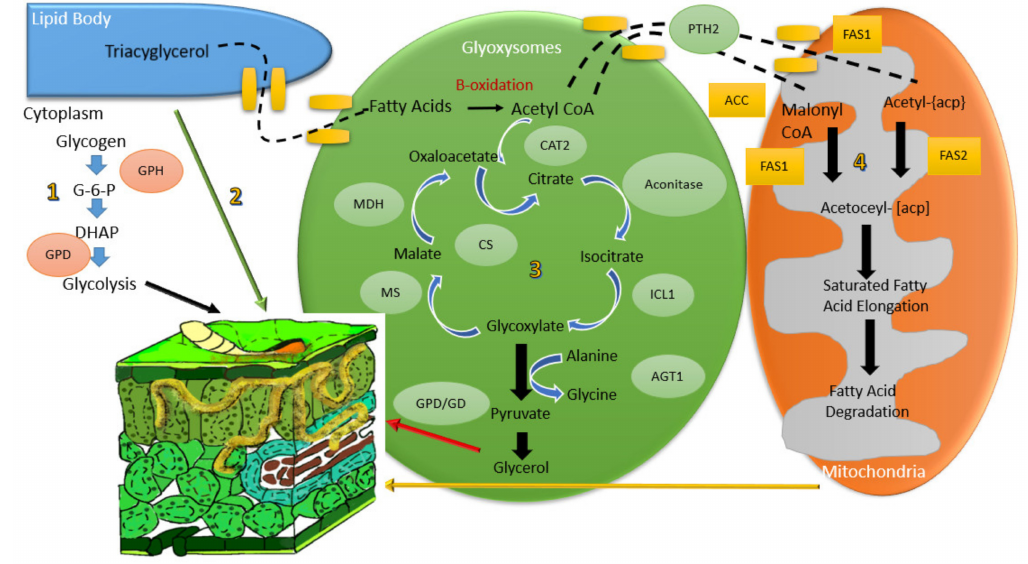
Figure 1. Model of turgor pressure generation involving fatty acids, glycogen, glycerol and triacylglycerols in M. oryzae. Pathway ( 1 ) is where glycogen is carried into the glycolysis pathway to produced pyruvate, which then enters Krebs cycle for energy production for penetration of fungus into host [25].